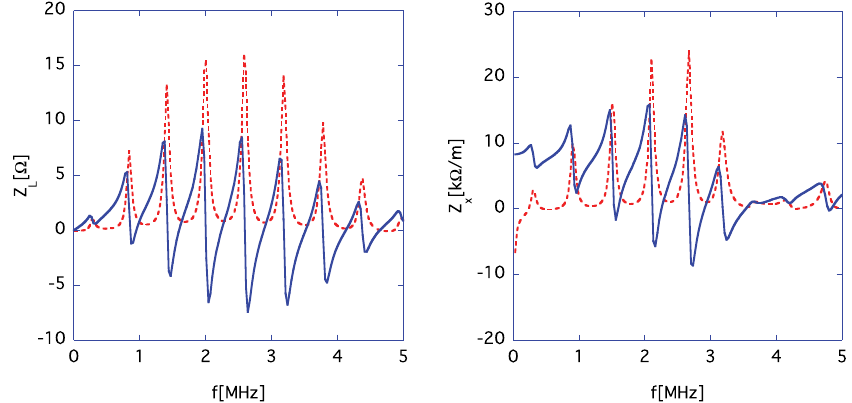
FIG. 10. Simulation results for the longitudinal and horizontal beam impedances, where the wire radius is ρ w ¼ 80 μ m and the twin- wire separation is Δ ¼ 60 mm. The red dashed and blue solid lines show the real and imaginary parts of the beam impedances, respectively.